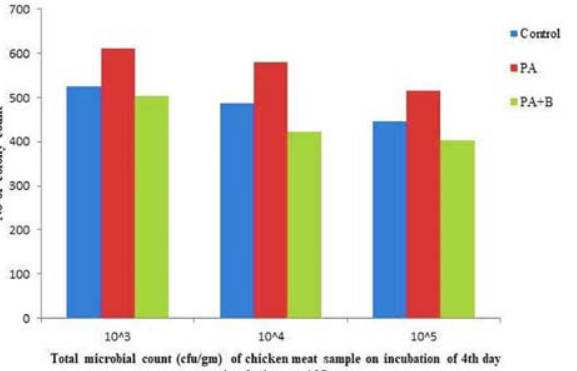
Fig. 2.4. Total microbial count of Chicken meat sample treated with strain and phage on 4 th day of Incubation at 4 °C.